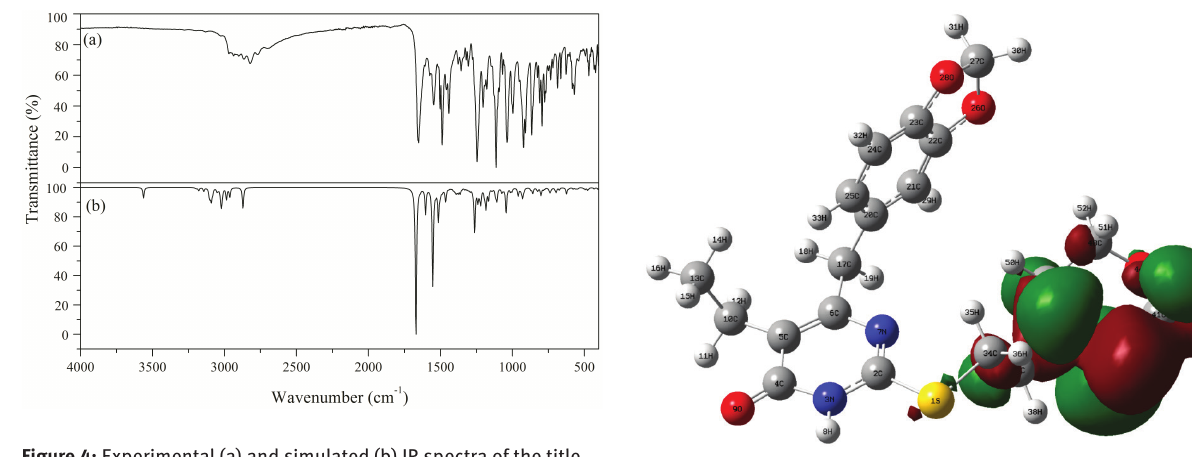
Figure 4: Experimental (a) and simulated (b) IR spectra of the title molecule.